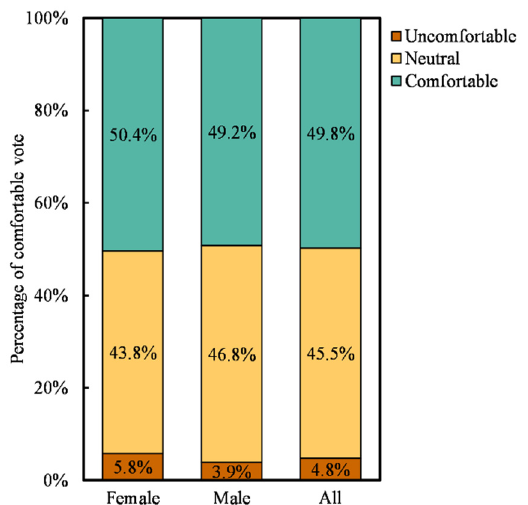
Figure 7. TCV of female and male children.